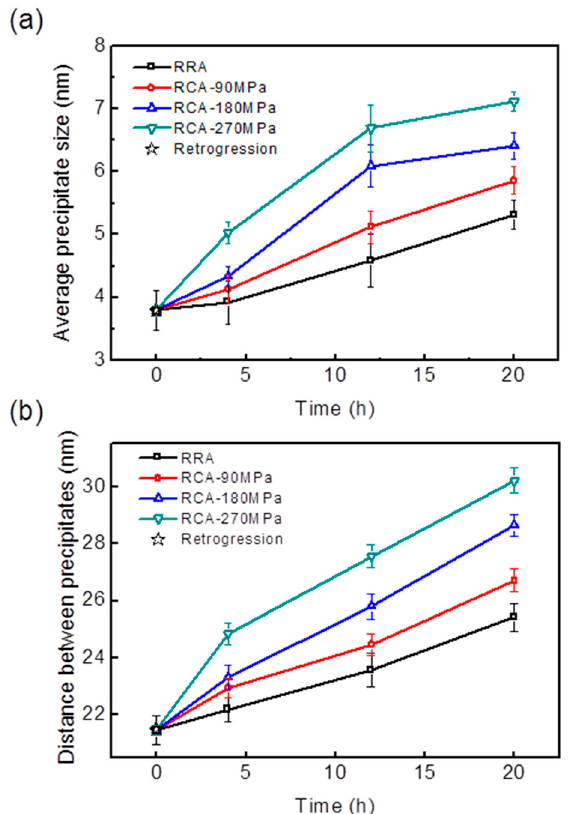
Figure 5. Evolutions of matrix precipitate (MPt) microstructures of the retrogressed 7B04-T651 aluminum alloy during aging treatments: ( a ) the average MPt size; ( b ) the mean space between MPts.